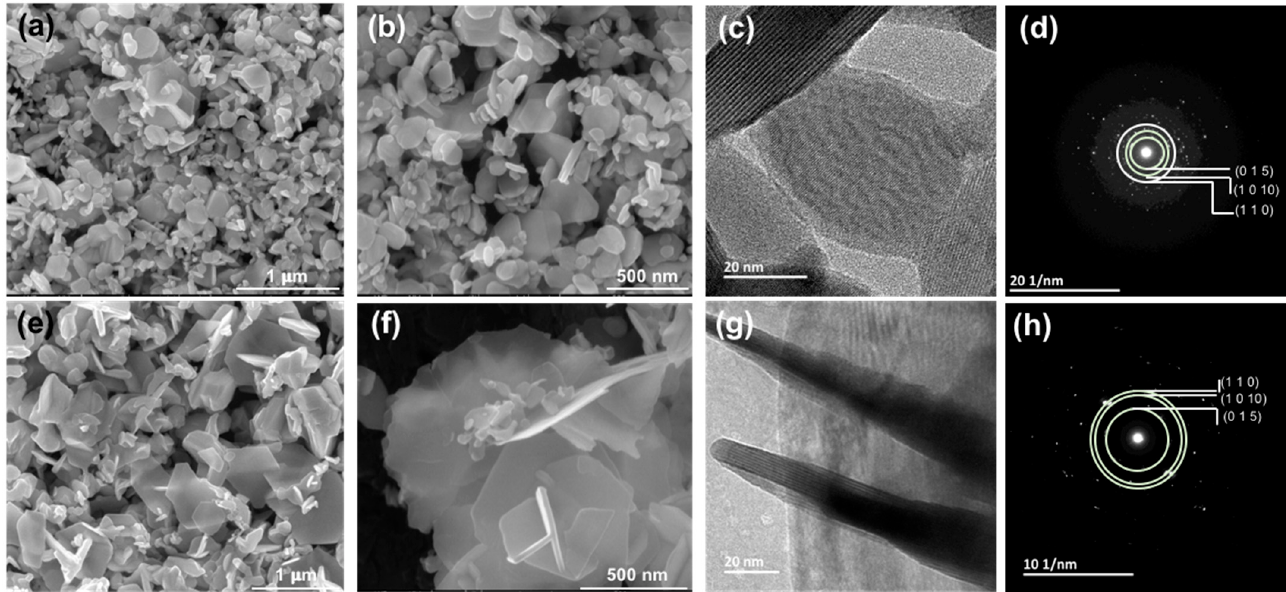
Figure 5. Scanning electron microscopy (SEM) micrographs of as-made Bi 2 Te 3 samples at different magnifications; ( a , b ) hydro-Bi 2 Te 3 and ( e , f ) polyol-Bi 2 Te 3 . ( c , g ) Transmission electron microscopy (TEM) micrographs and ( d , h ) selected-area electron diffraction (SAED) patterns of hydro-Bi 2 Te 3 and polyol-Bi 2 Te 3 samples, respectively.